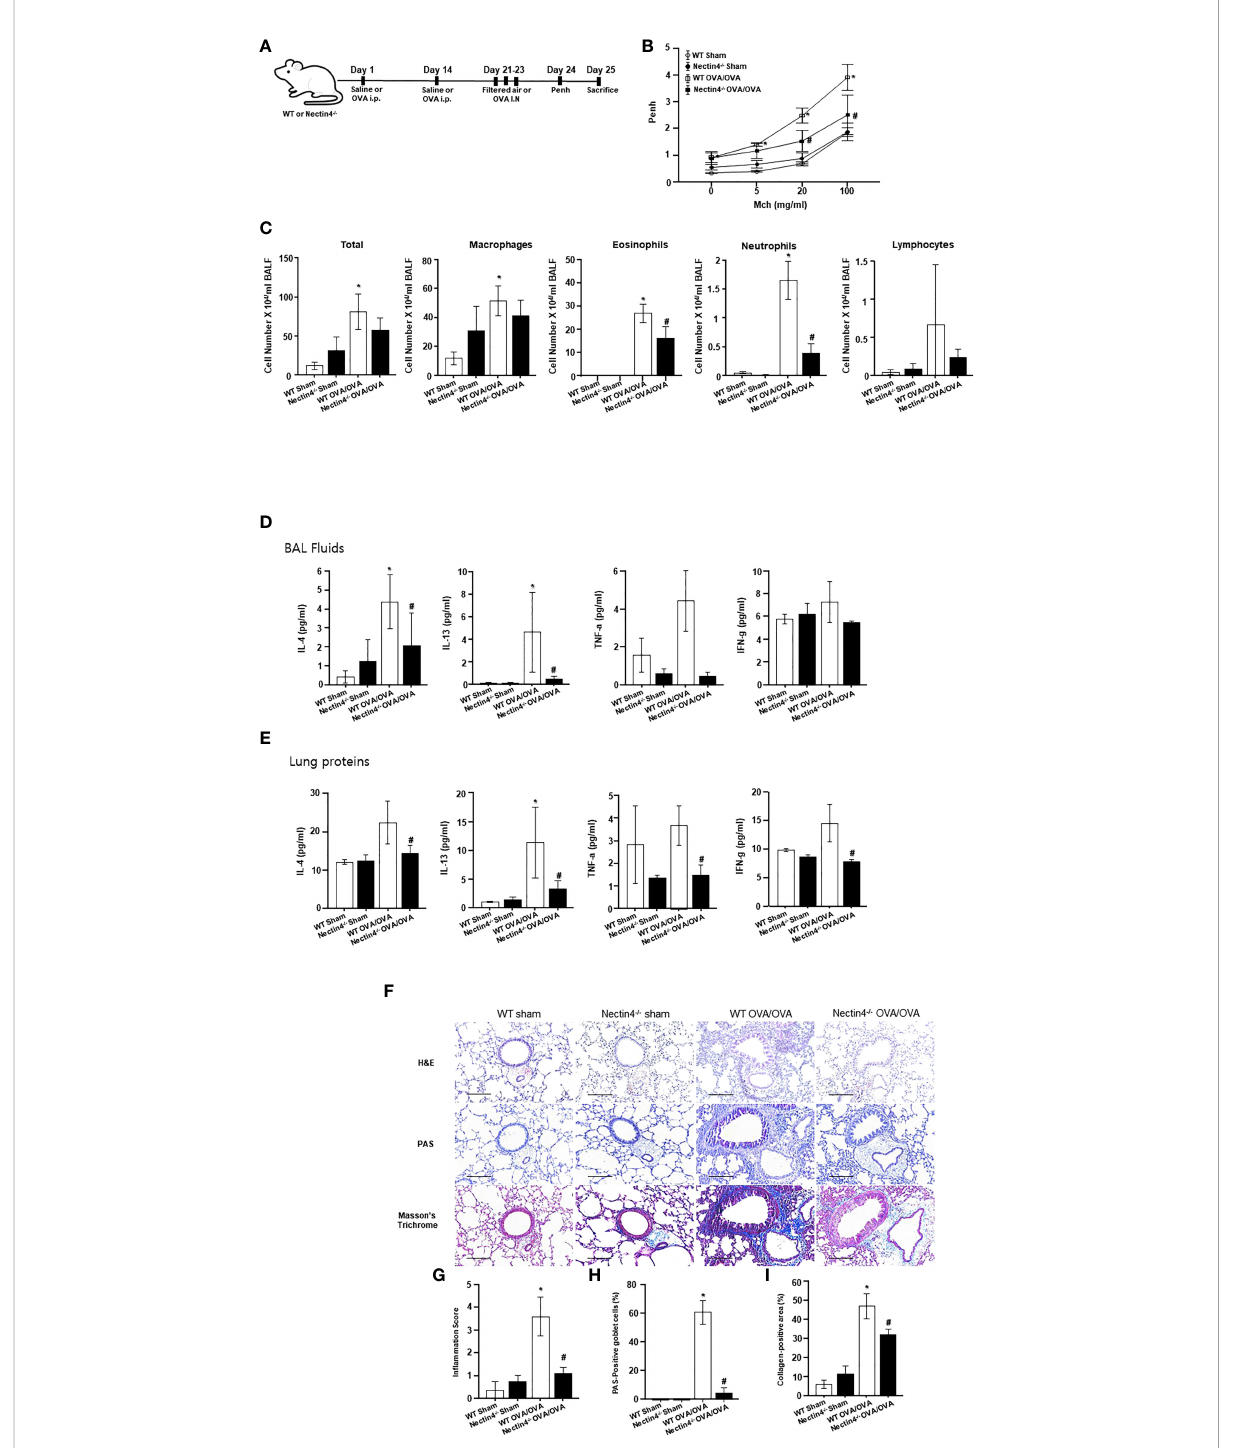
FIGURE 5 Absence of Nectin4 prevents development of OVA-induced asthma. (A) Scheme representing the acute ovalbumin-dependent asthma model of WT and Nectin4 -/- mice. (B) Airway hyperresponsiveness in response to methacholine (Mch) (n = 6-10 mice per group). (C) In fl ammatory cells in BAL fl uid. (D, E) Levels of IL-4, TNF-a, and IFN-g in BAL fl uids and Lung proteins (n = 6-10 mice per group). (F) Representative images of H&E, PAS, Masson ’ s trichrome-stained, paraf fi n-embedded lung sections of asthmatic mice (scale bar = 50 m m). (G-I) . Bar graphs summarize means ± SEMs of histological scoring of in fl ammation grading based on H&E staining, the number of goblet cells based on PAS staining and of fi brosis based on trichrome staining. * p<0.05 vs. WT sham. #p<0.05 vs. WT